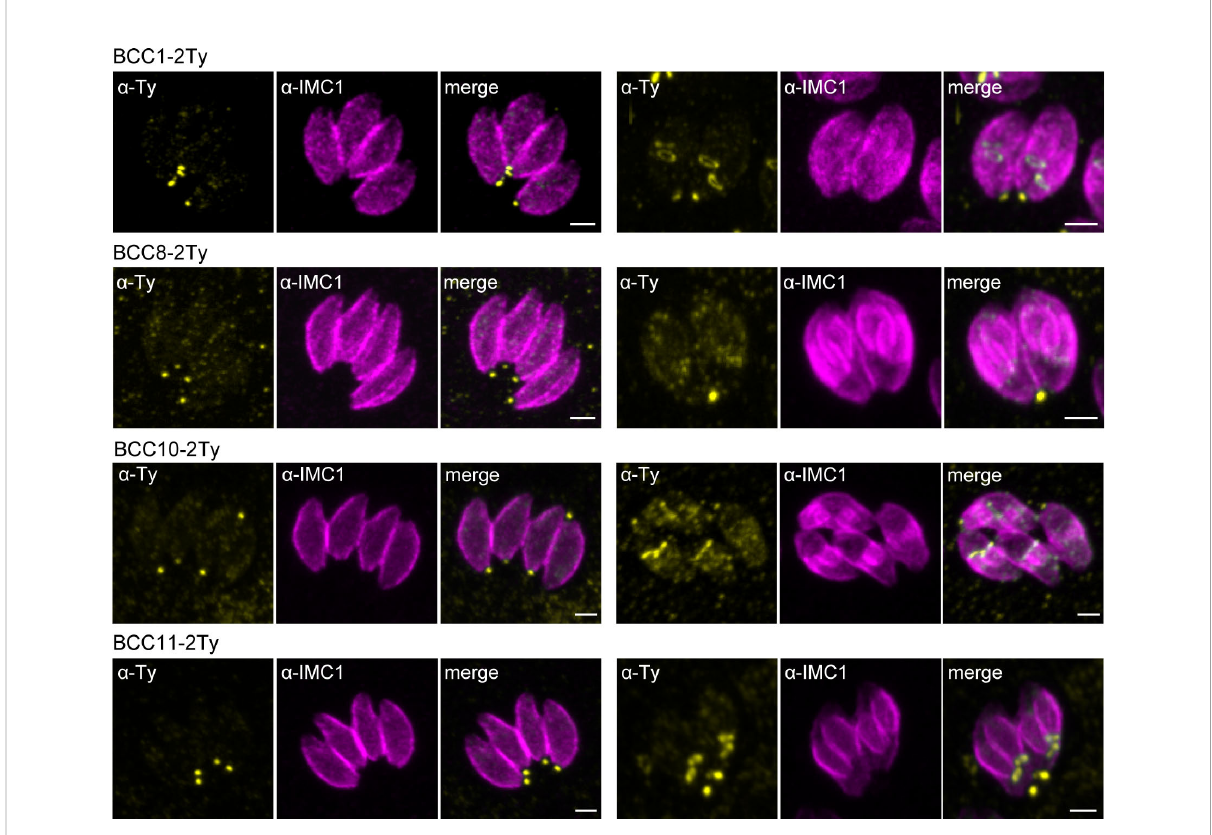
FIGURE 3 BCCs present to the basal complex all along the IMC elongation. Immuno fl uorescence assays performed on parasites expressing the endogenously tagged version of BCC1, BCC8, BCC10, and BCC11 show that all these BCCs cap the basal end of the IMC during the development of the daughter cells and in the mature parasites. Magenta: rabbit anti-IMC1, Yellow: mouse anti-Ty. Scale bars: 2 m